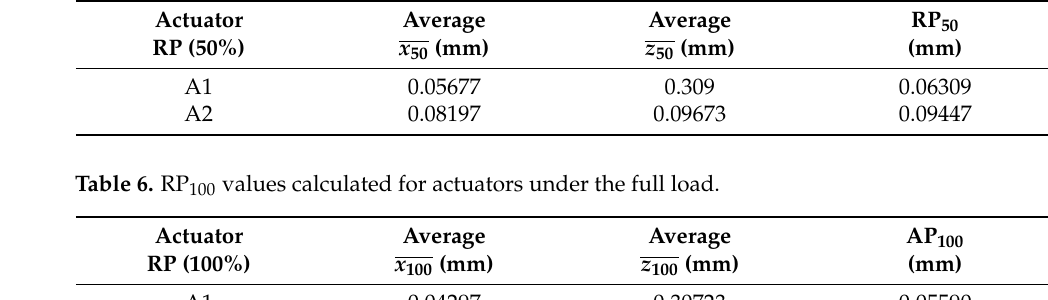
Table 5. RP 50 values calculated for actuators under half the load.